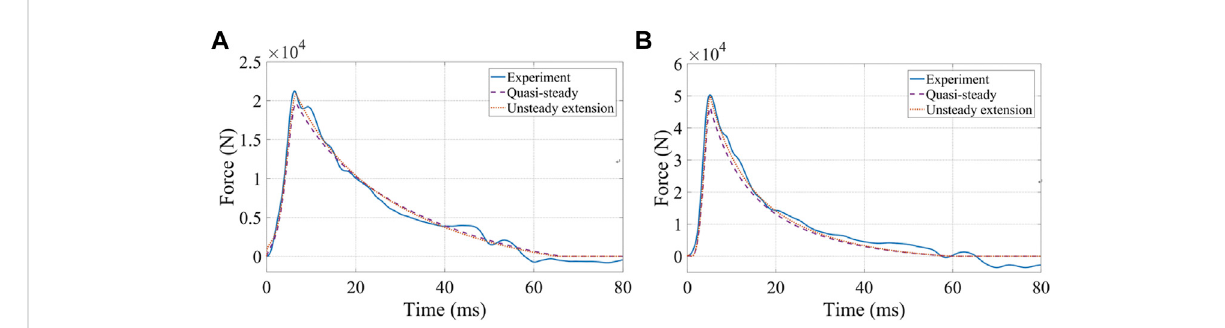
FIGURE 7 The force between the experiments and the models at zero fi eld: (A) 1.5 m/s; (B) 3.0 m/s.